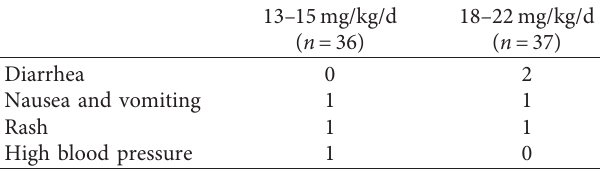
Table 8: Adverse reactions through the course of the